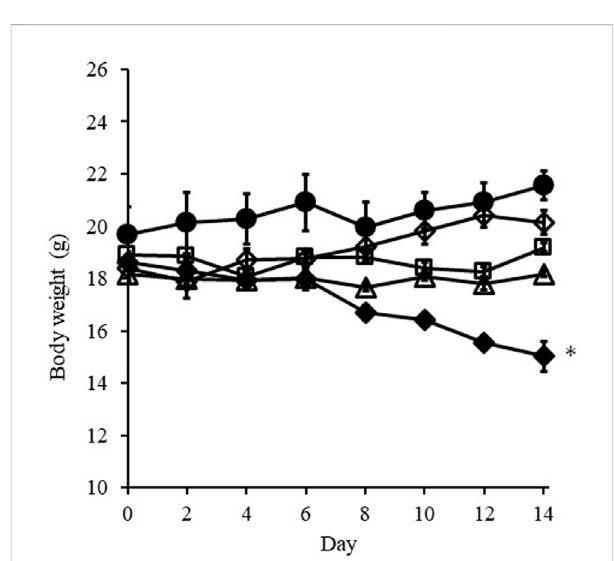
FIGURE 5 Change in body weight of mice treated with i.v. injection or i.t. administrationofDXRover14 days.Symbols; ○ : i.v. injectionofPBS, ◇ : i.v. injectionofDXRatadoseof20 μ g, □ : i.t. administrationofDXRwith a syringe at a dose of 20 μ g, △ : i.t. administration of DXR with EO pump at a dose of 20 μ g, ◆ : i.v. injection of DXR at a dose of 100 µg. Each point shows the mean ± S.E. ( n = 5). * Signi fi cant difference ( p < 0.05)wasobservedcomparedwith i.v. injectionofPBS.Whitedotsline shows that tumor, and the red dotted line shows the red color derived from DXR